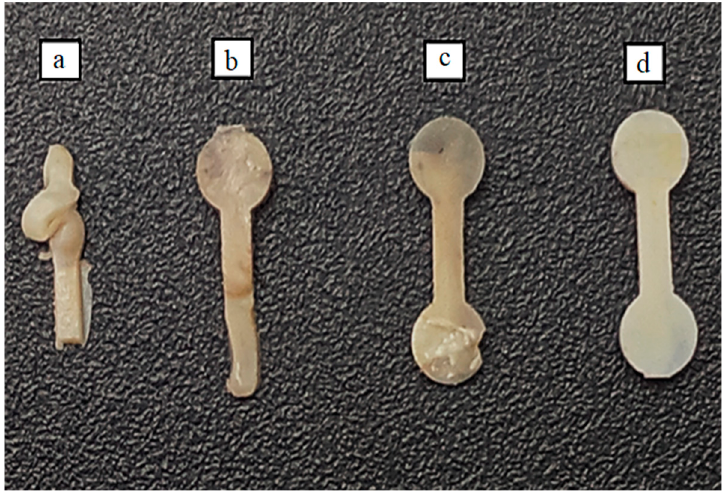
Figure 9. Injected micro-shaped 3YSZ parts at different mold temperatures: ( a ) 50 °C; ( b ) 55 °C; ( c ) 60 °C; and ( d ) 65 °C. Table 3. Injection molding parameters to produce SS 17-4PH and 3YSZ micro-parts.